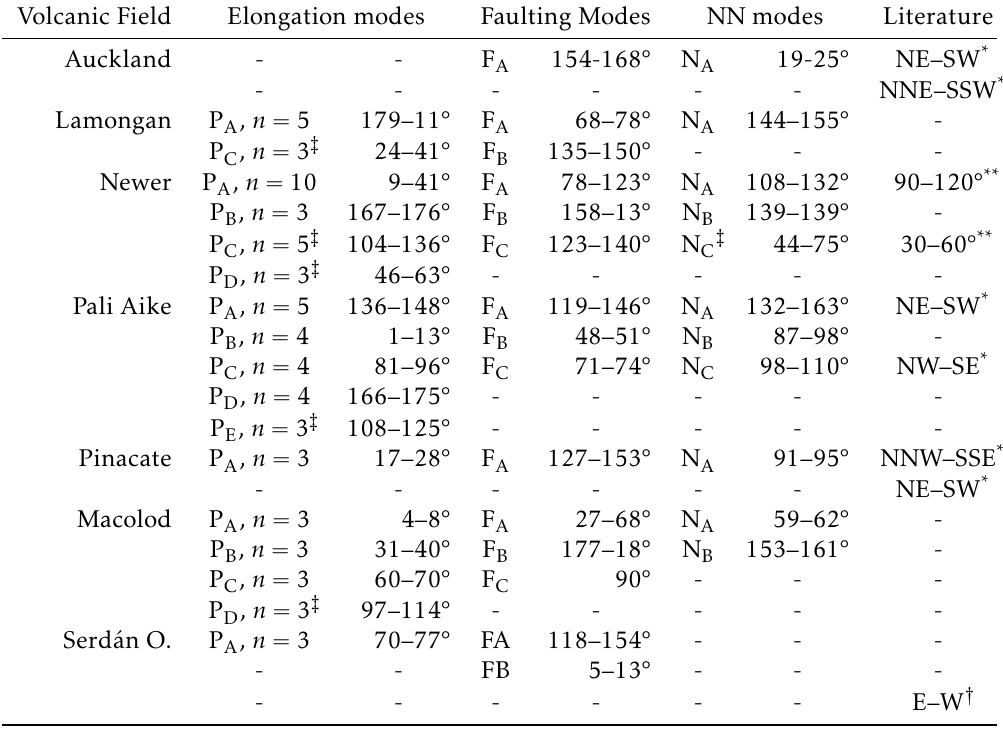
Table 1: Summary of modes identified in this study and related literature. Volcanic